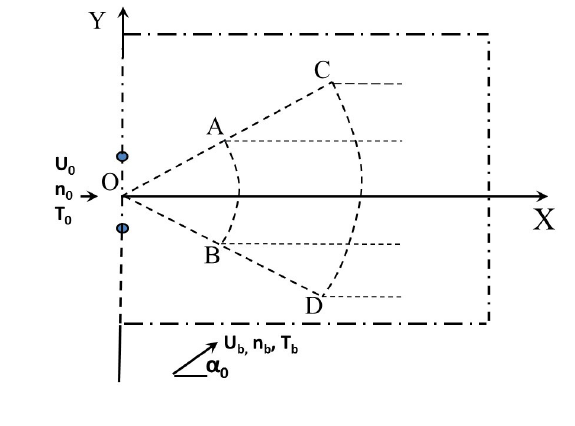
Figure 12. Background flow effects on the local number flux (normalized by n 0 along r / ( 2 H ) = 4., n b / n 0 = 0.5, S 0 = 0.2, S b = 0.1, T 0 = 200 Kelvin, and T b = 300 Kelvin.